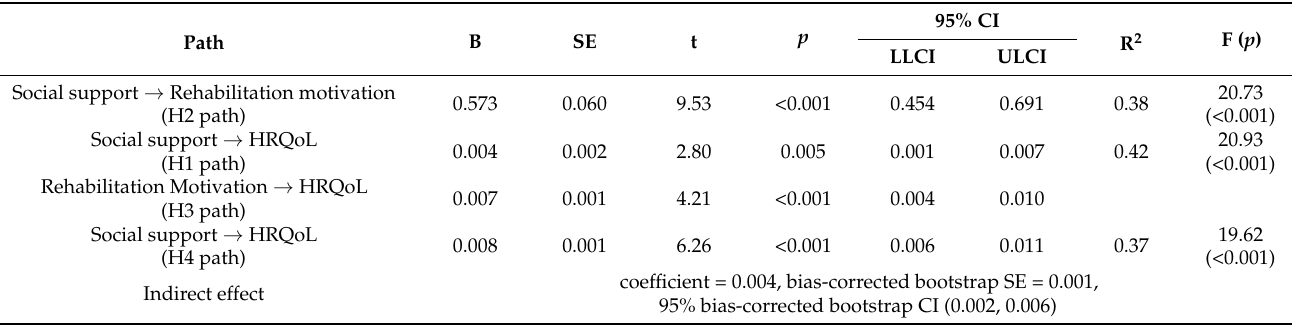
Table 3. Mediating effect of rehabilitation motivation on the relationship between social support and health-related quality of life ( n = 174).